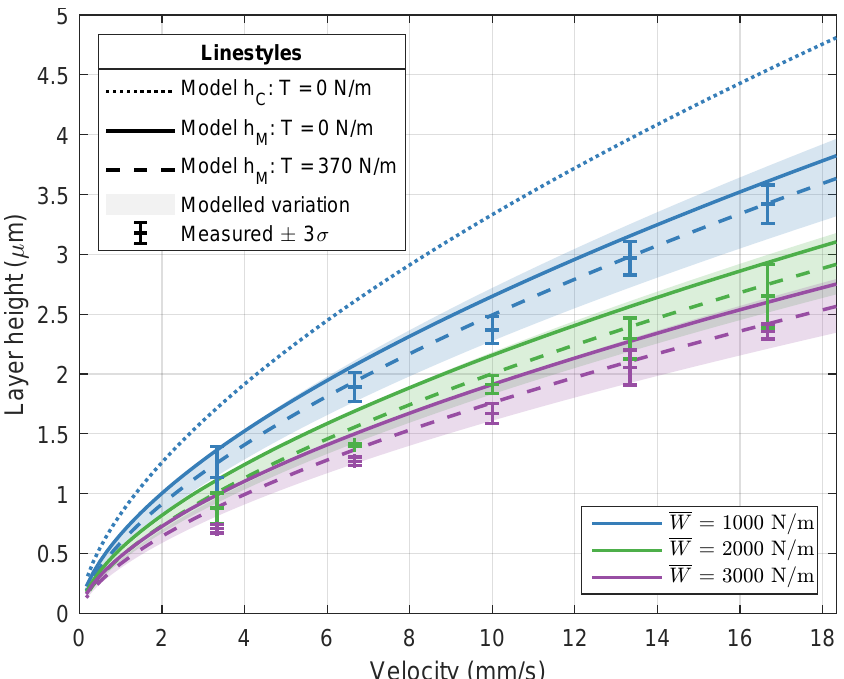
Figure 6. Numerical and experimental results for the layer height for varying imprint loads and imprint velocities. The modeled results include a ± 10% variation in both elastic modulus of the elastomeric layer and resin viscosity. The simulations and imprints are performed with Resin B from Table 1 (viscosity of 38mPas).